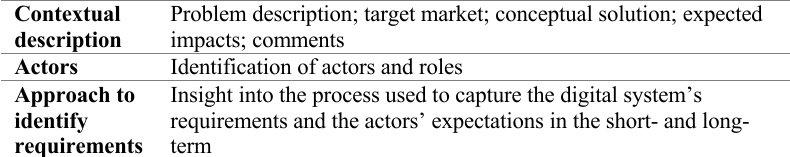
Table 1. Basic data capture for the